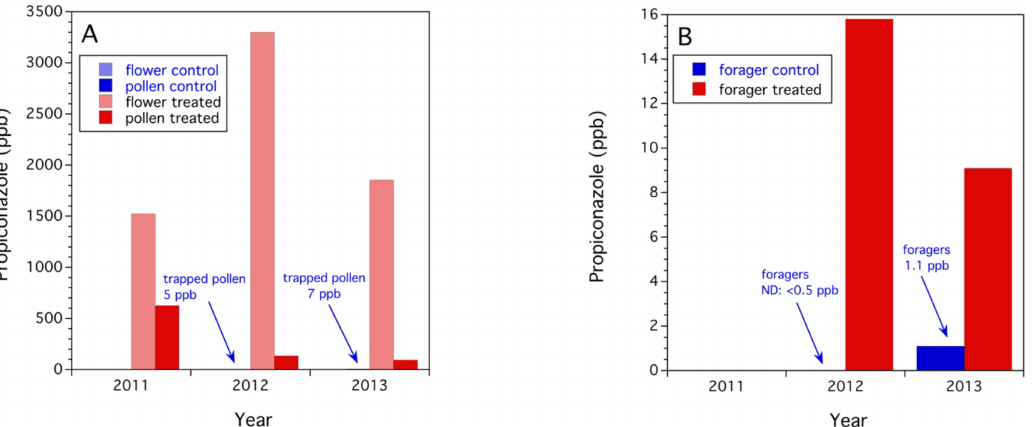
Figure 6. Propiconazole residues in treated and control fields, 2011–2013, on flowers and trapped pollen ( A ); and foraging workers returning to the hive (2012–2013) ( B